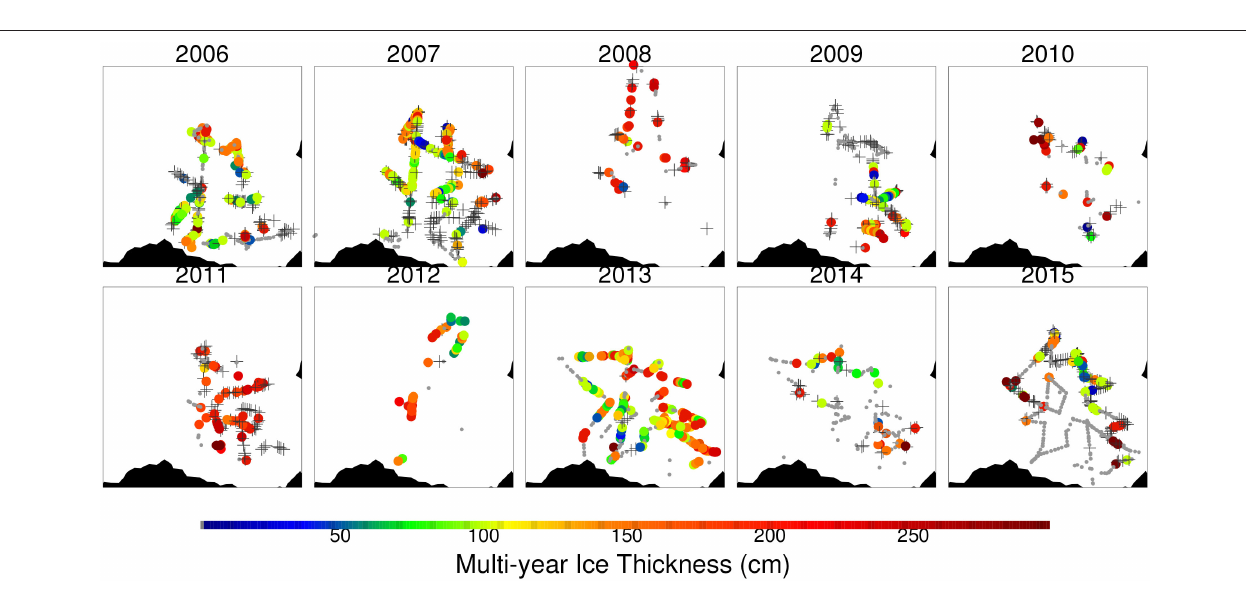
FIGURE 4 | Multi-year ice thickness. Observations where no multi-year ice was present are shown as small gray circles. Crosses show where multi-year ice was observed but a thickness estimate not